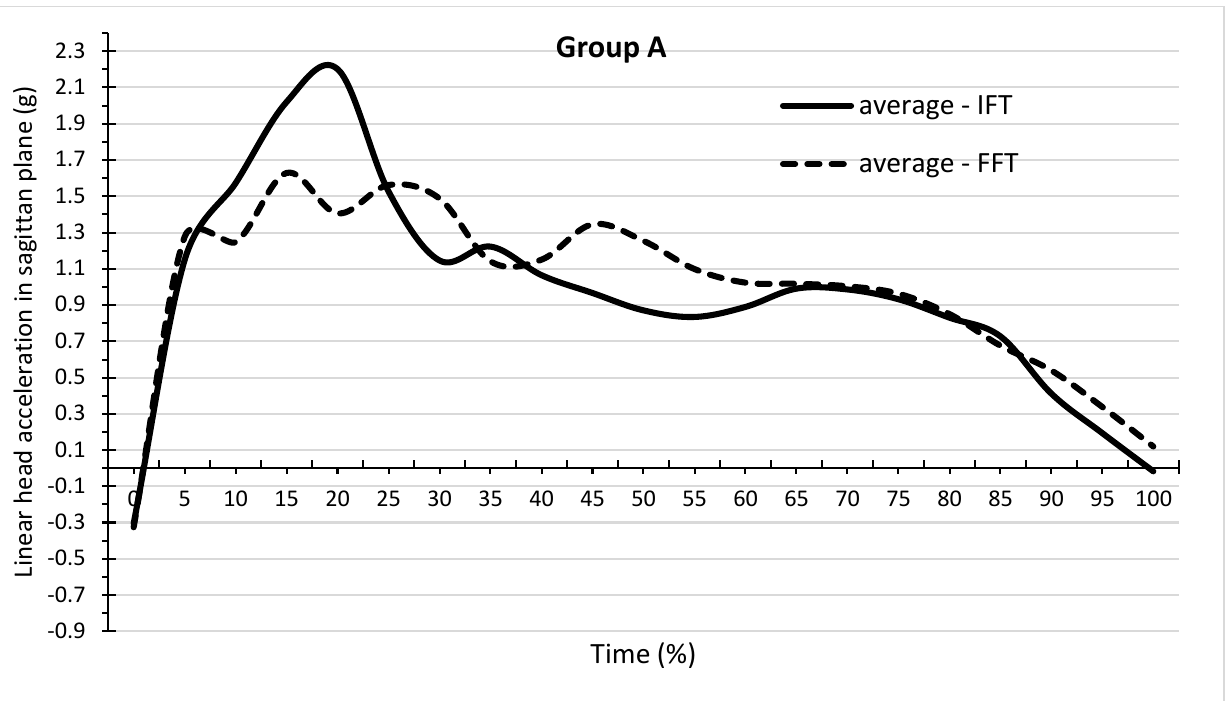
Figure 5. Dependence of mean values of linear head acceleration in the sagittal plane on the time of performing a backward fall in the form of IFT and FFT in group A, which consisted of students training in martial arts.